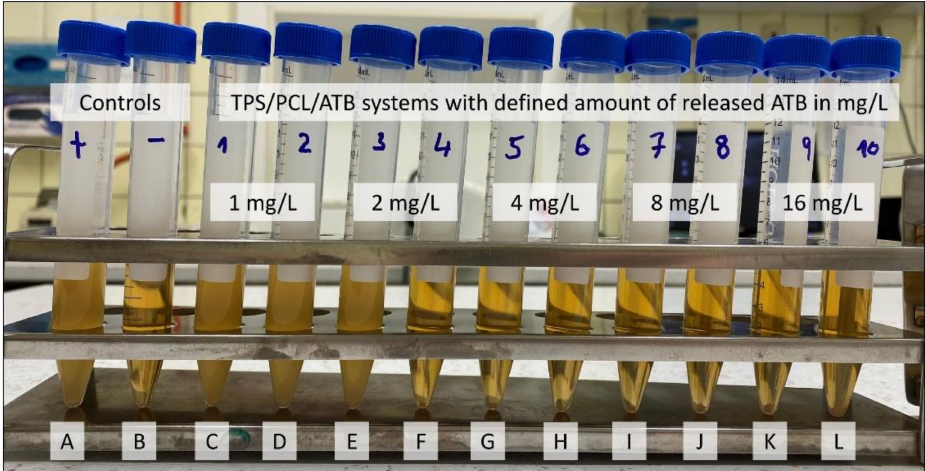
Figure A1. The results of standard microbiological tube dilution tests, in which a defined piece of TPS/PCL/ATB sample (ATB dispersed in TPS phase) was put into a tube containing 5 mL of Mueller-Hinton broth (Oxoid, Brno, Czech Republic); each tube is then inoculated with a standardized bacterial suspension of the CCM 4223 Staphylococcus aureus and observed after 24 h. The turbid solution observed in positive control ( A ) and tubes containing TPS/PCL/ATB systems with lower concentrations of ATB ( C – E ) indicated the growth of bacteria, while the clear solution observed in negative control ( B ) and tubes containing TPS/PCL/ATB systems releasing higher concentrations